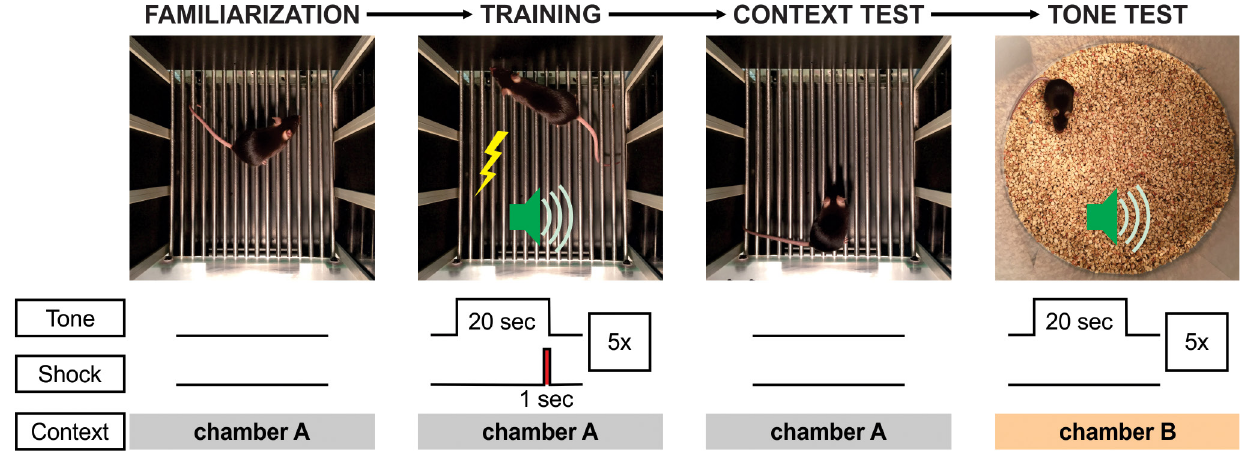
Figure 2. Protocol for associative fear conditioning. Male C57BL/6 mice are subjected to this 3 d paradigm at 6 wks post-surgery. For familiarization (d 1), each animal is exposed to Chamber A for 10 min. For training (d 2), the mouse is conditioned with five pairings of tone CS (20 s, 5 kHz, 80 dB) that coterminates with a foot-shock US (1 s, 1 mA) in Chamber A. For the context test (d 3), the animal is placed in Chamber A for 10 min. For the tone test (d 3), the mouse is placed in Chamber B, in which it received five tones (20 s, 5 kHz, 80